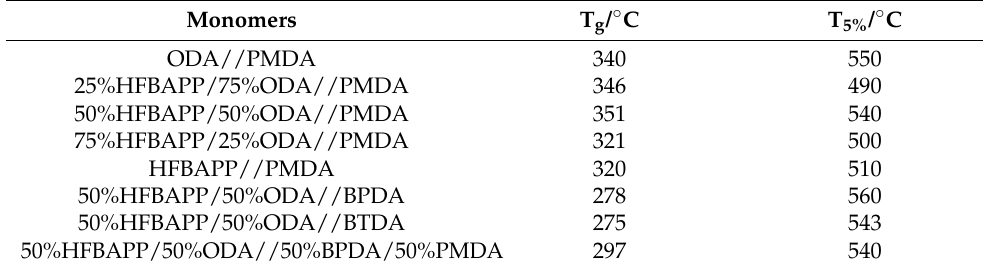
Table 2. Thermal properties of PI films in group HFOP and group HFOB.